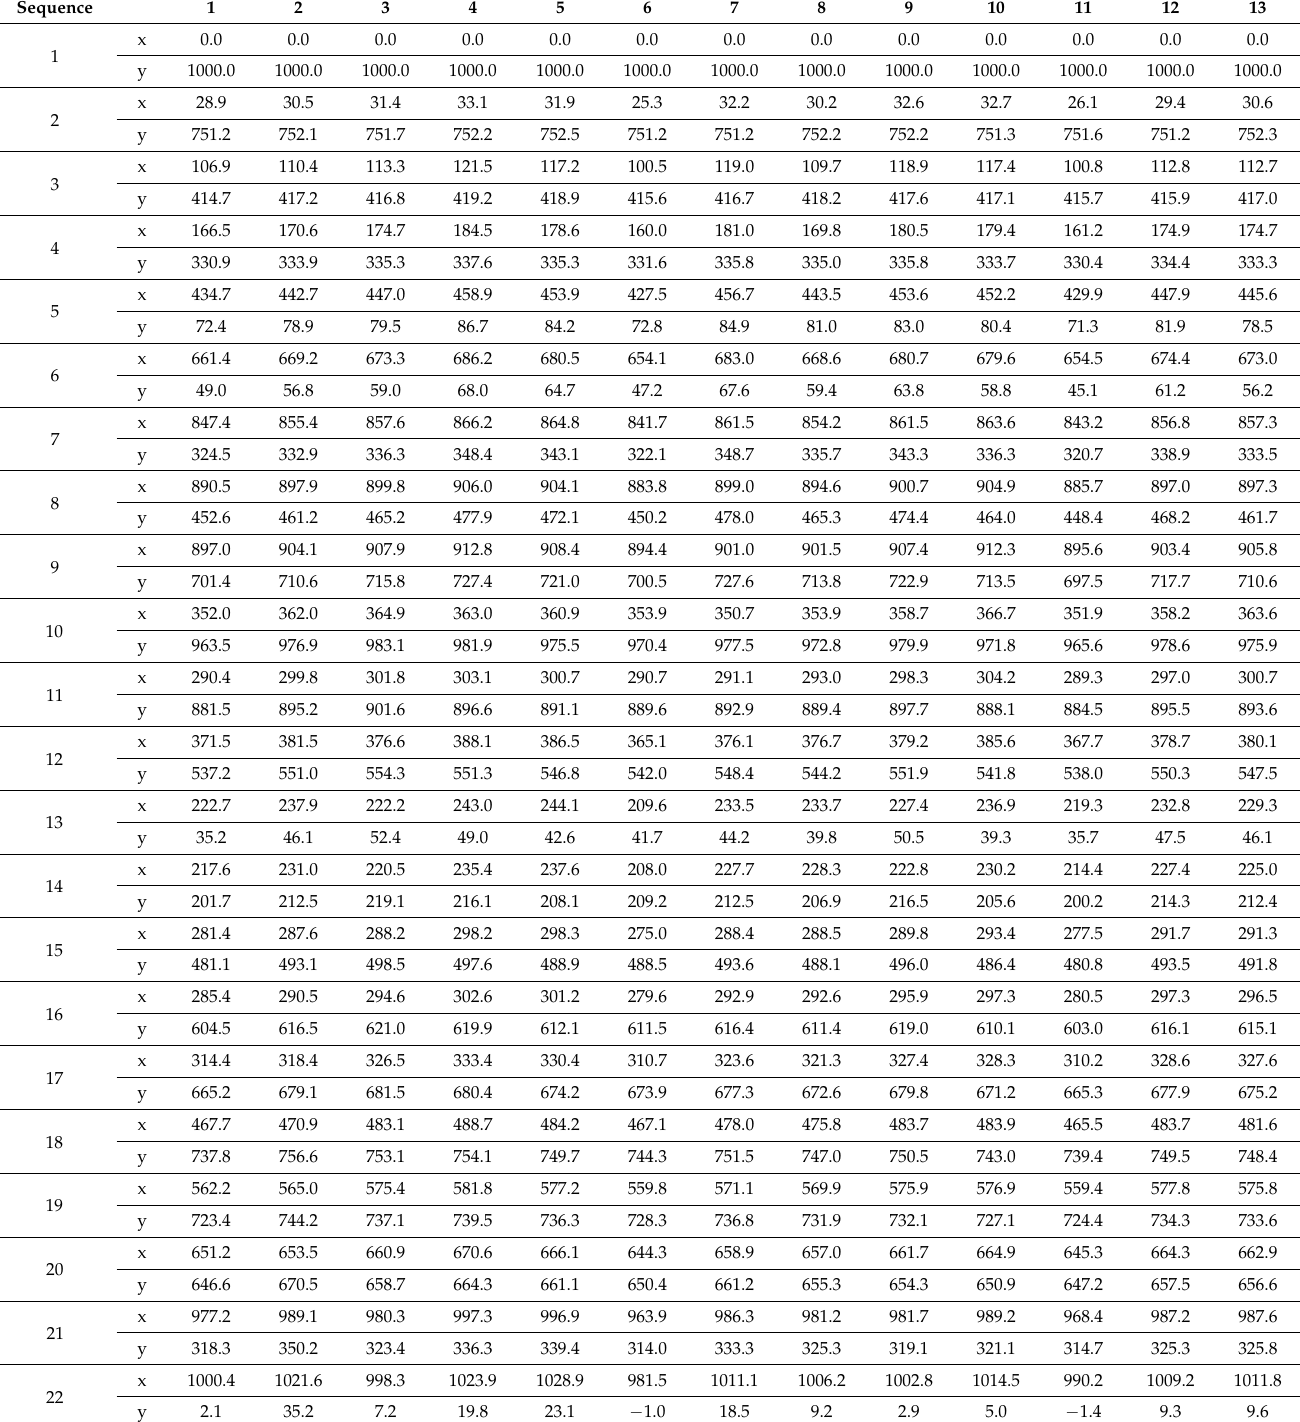
Table A9. Experiment data when moving along the path with the least rotation. The movement commands are compensated